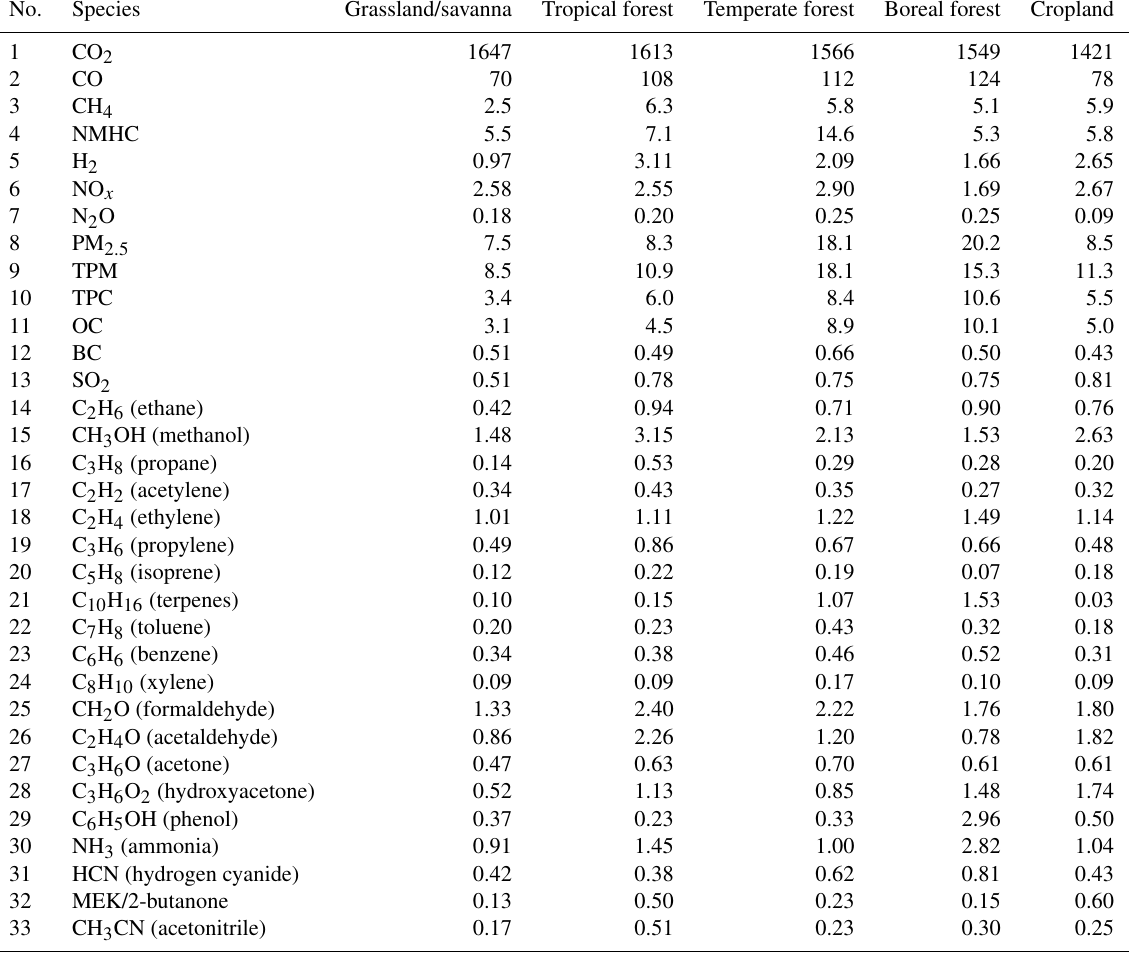
Table 3. Emission factors (gspecies (kgDM ) − 1 ) for land cover types